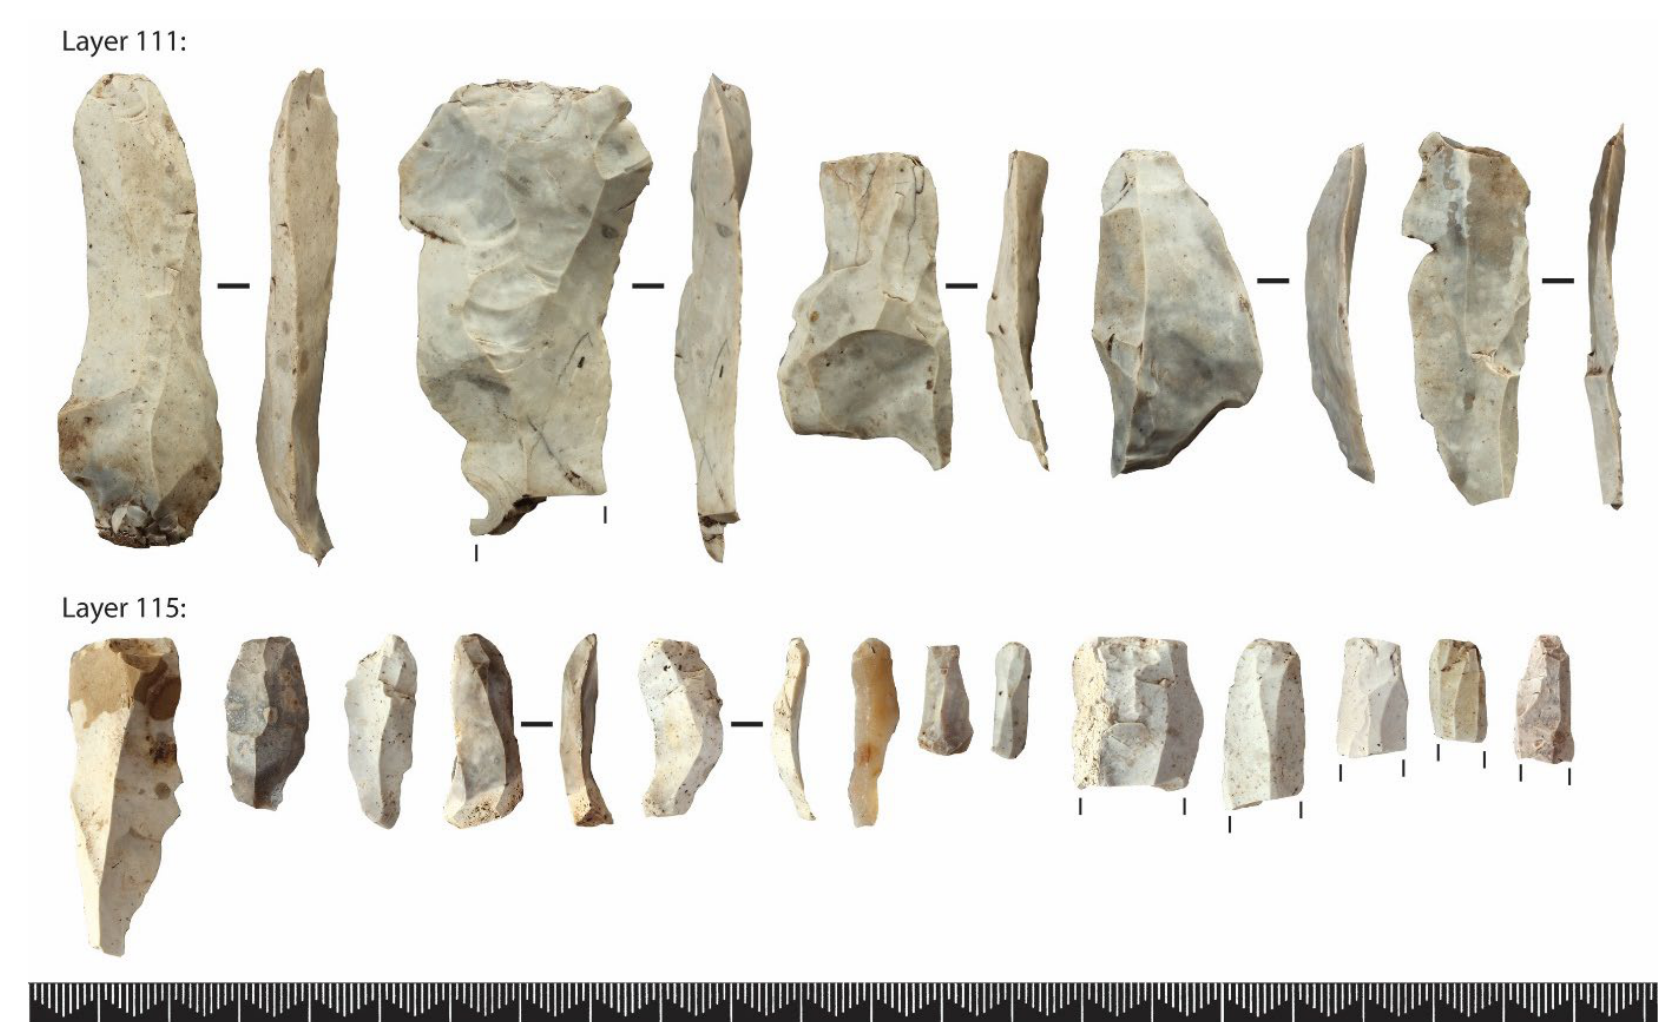
Figure 6. Concept 1 and Concept 2 blades from RPAS (scale bar: cm and